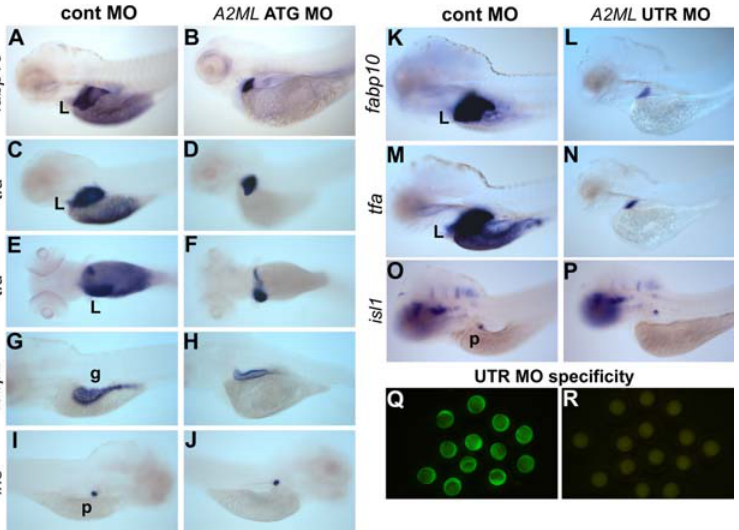
Figure 4. Whole mount in situ hybridization of A2ML knock-down embryos. The indicated MOs were injected and embryos were stained at 5dpf A–J or 6dpf K–P . A, B, K, L. Lateral views of fabp10- stained embryos. C–F, M–N. Lateral (C, D, M, N) and dorsal views (E–F) of tfa expression. G– H. Lateral views of fabp2 expression. I–J. Lateral view of insulin expression, and O–P. islet1 expression in the pancreas. Q–R. Specificity test using the UTR MO at the 3-somite stage; see Fig. 2K–L.